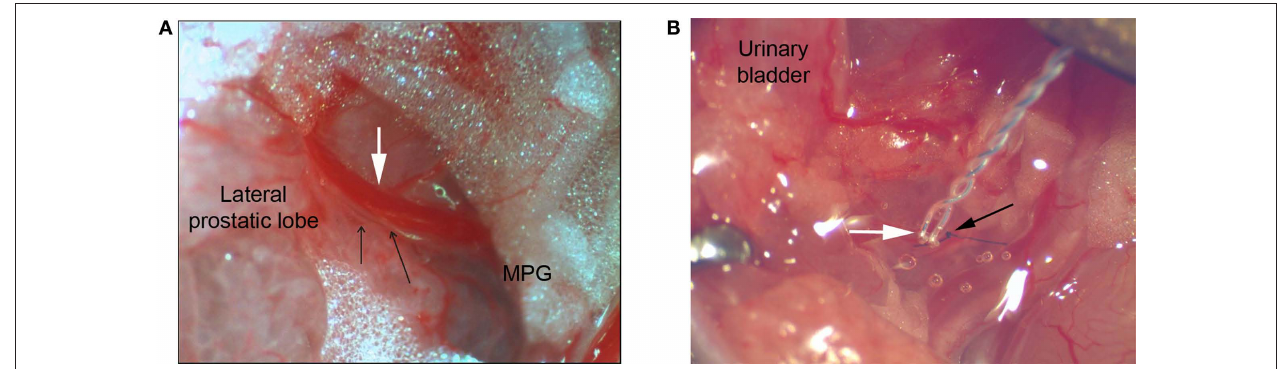
exposed hook-shaped poles lying beneath the postganglionic bladder nerve (marked by white arrow), embedded in the clear transparent silicone